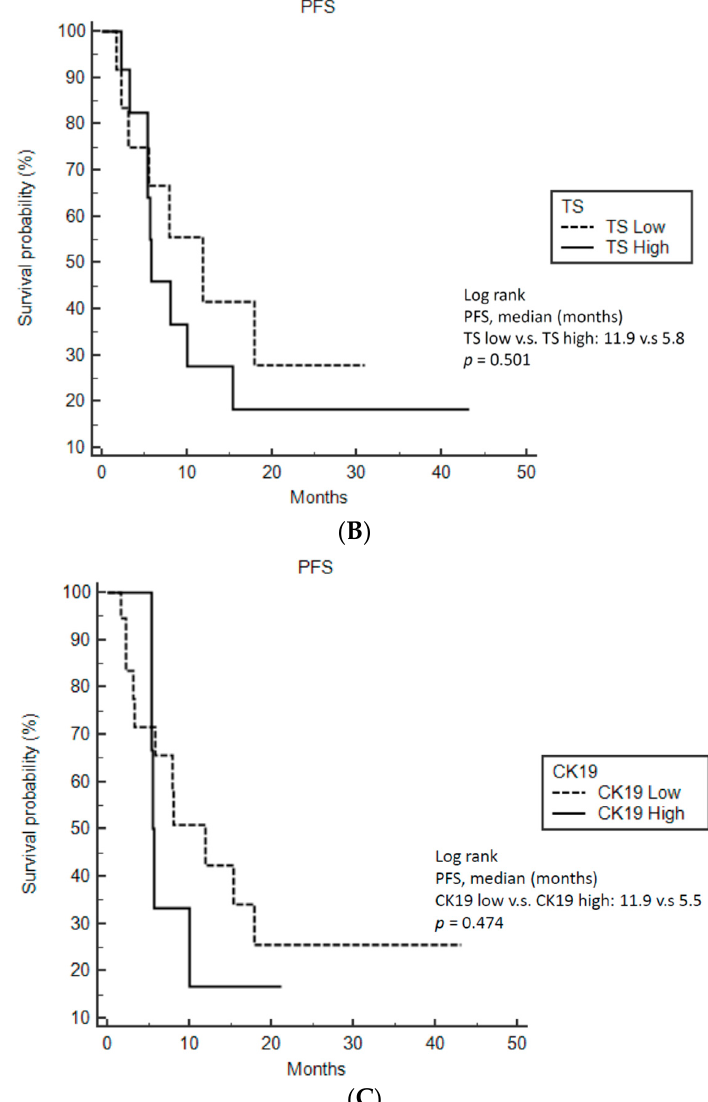
Figure 3. Expression level of plasma biomarker affects progression-free survival (PFS) plots by Kaplan–Meier survival analysis. ( A ) Patients with low and high levels of astrocyte-elevated gene-1 (AEG-1) expression are illustrated. PFS for patients with low AEG-1 expression was significantly longer (low vs. high, 11.9 vs. 5.5 months, p = 0.02, log rank test). ( B ) Patients with low and high levels of thymidylate synthase (TS) and, ( C ) CK19.